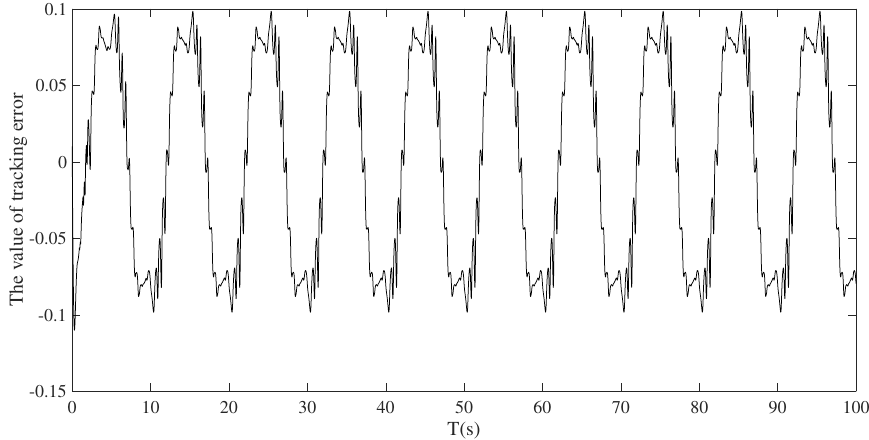
Figure 2. Tracking error curve in known time-varying delay form (with dead-zone compensation controller).